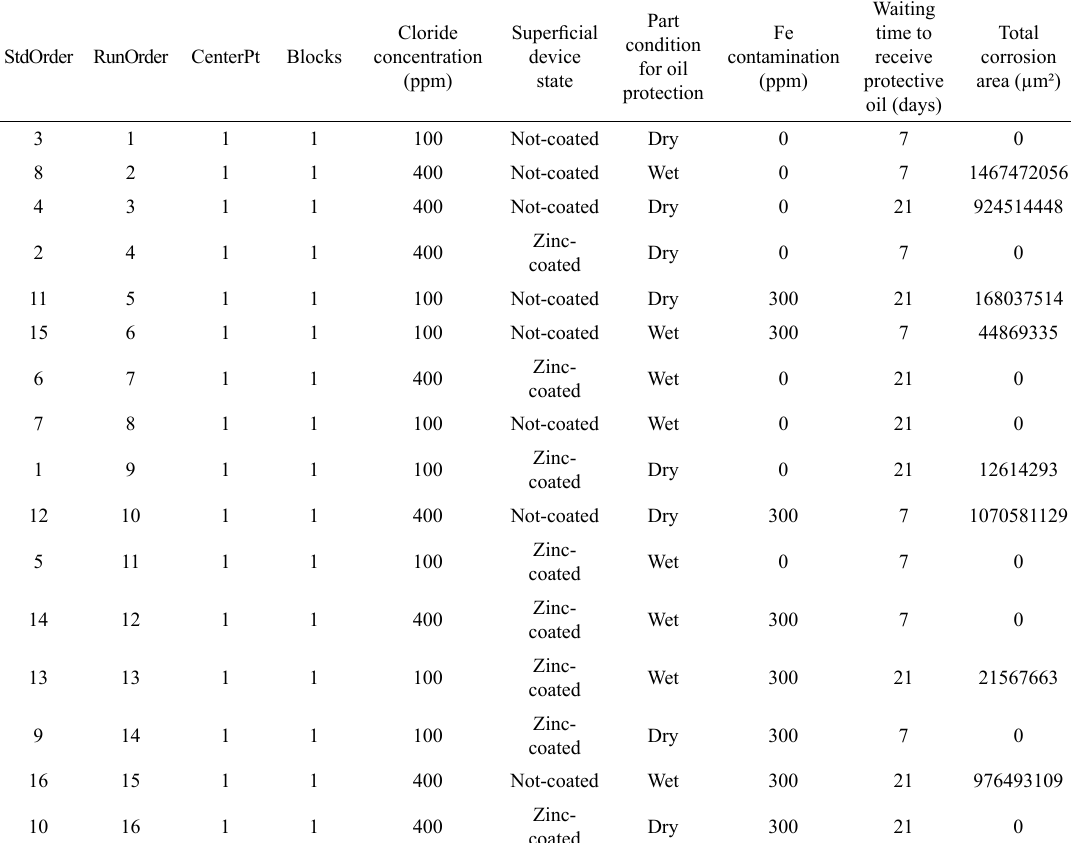
Table 2. 2 5-1 fractional factorial design for control factors and their respective levels (according to Table 1 ) and response variable (total corroded area)